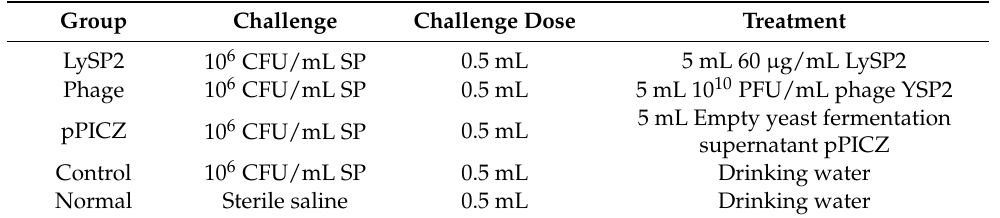
Table 2. Chick grouping and processing.